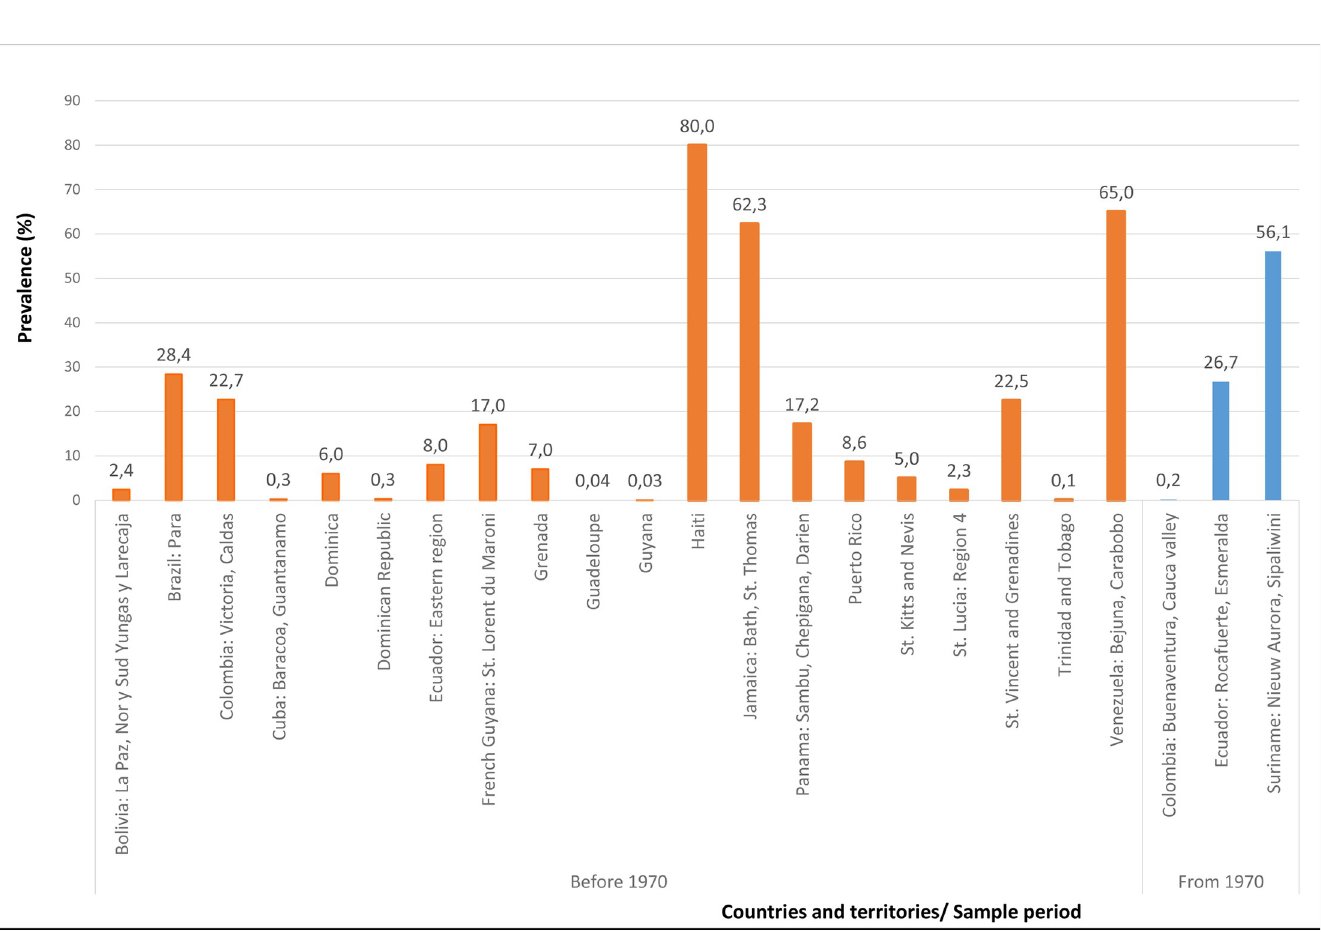
Fig 1. Prevalence of yaws (maximum) in general population by country or territory and sample